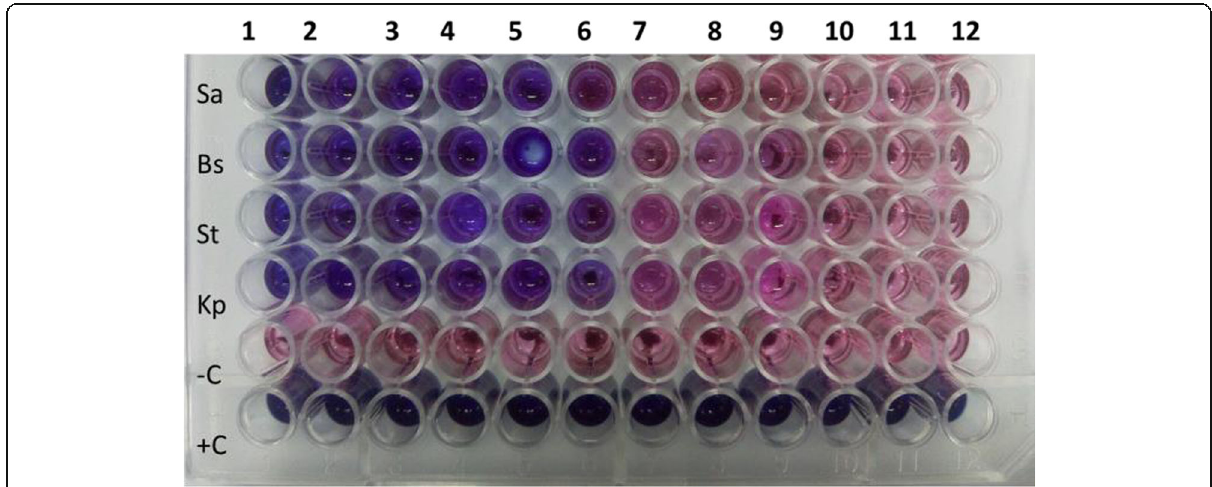
Fig. 6 MIC of root extract of S. heyneanus. Sa, Staphylococcus aureus ; Bs, Bacillus subtilis ; St, Salmonella typhi ; Kp, Klebsiella pneumonia ; – C, negative control; +C, positive control